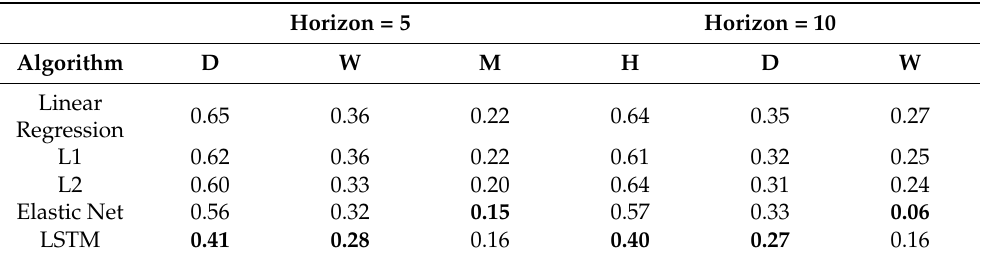
Table 2. Mean squared errors (MSE) obtained by the algorithms using different data grouping modes: 1 data/day (D), 1 data/week (W) and 1 data/month (M). The prediction horizons used were 5 and 10